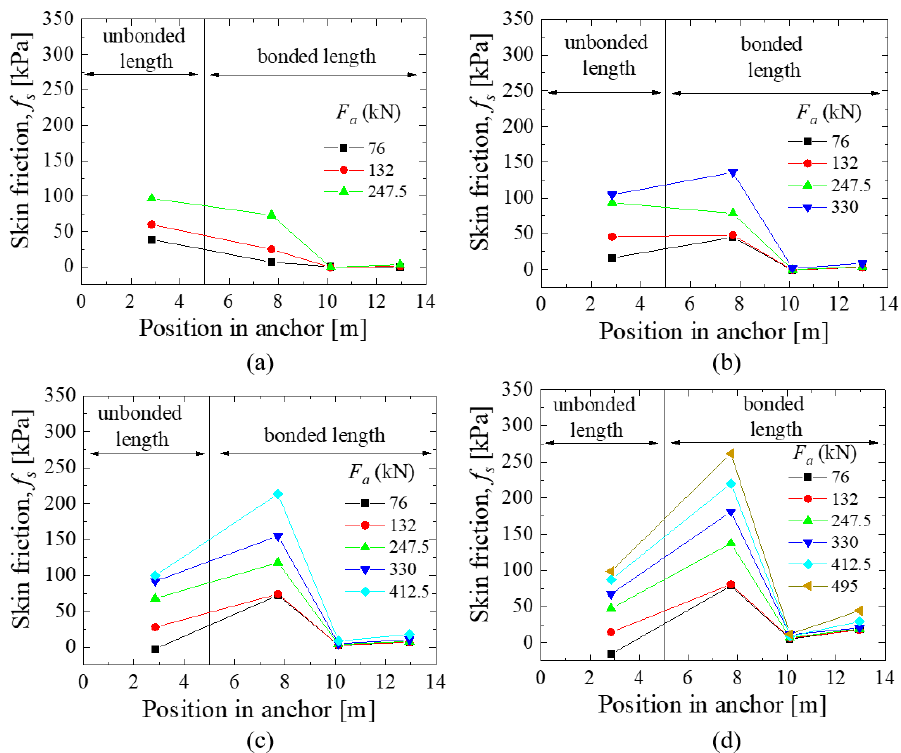
Figure 18 - Skin friction distribution on anchor T33: (a) 1st loading stage; (b) 2nd loading stage; (c) 3rd loading stage; (d) 4th loading